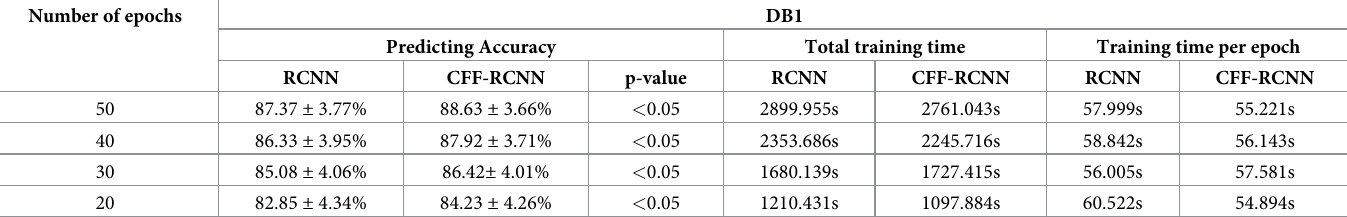
Table 4. Predicting accuracy, total training time, and training time per epoch of the RCNN and CFF-RCNN on DB1 at different epochs, along with the statistical analyses results. Number of epochs